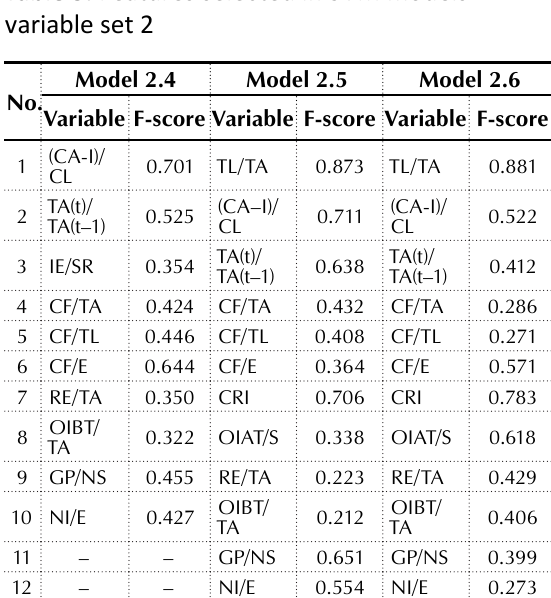
Table 6. Logistic regression